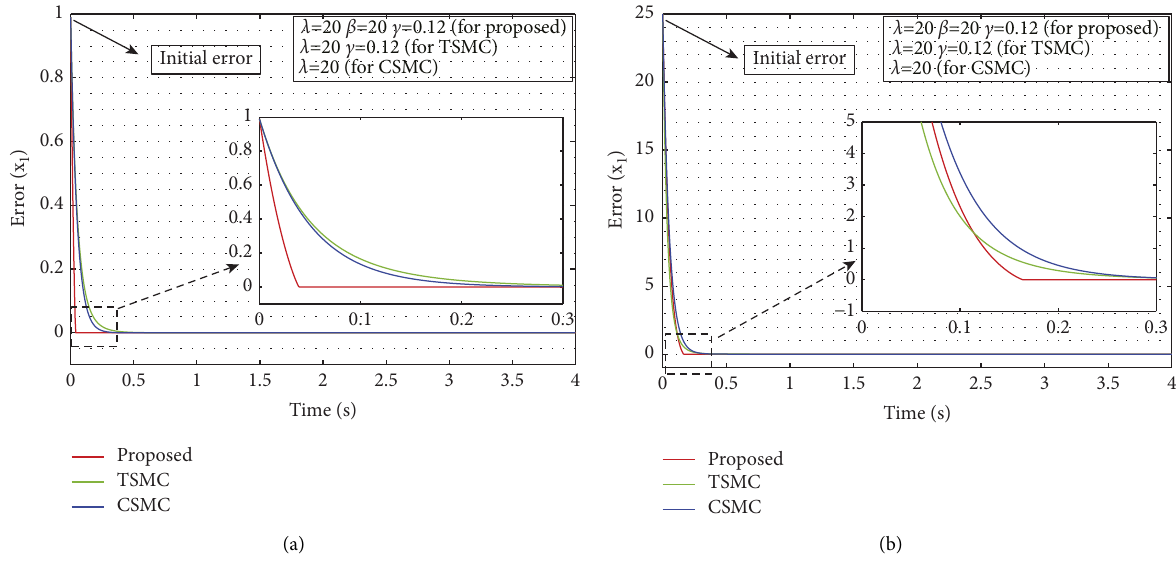
Figure 6: Error trajectory of TSMC, CSMC, and proposed method: (a) near initial error; (b) far away initial error.